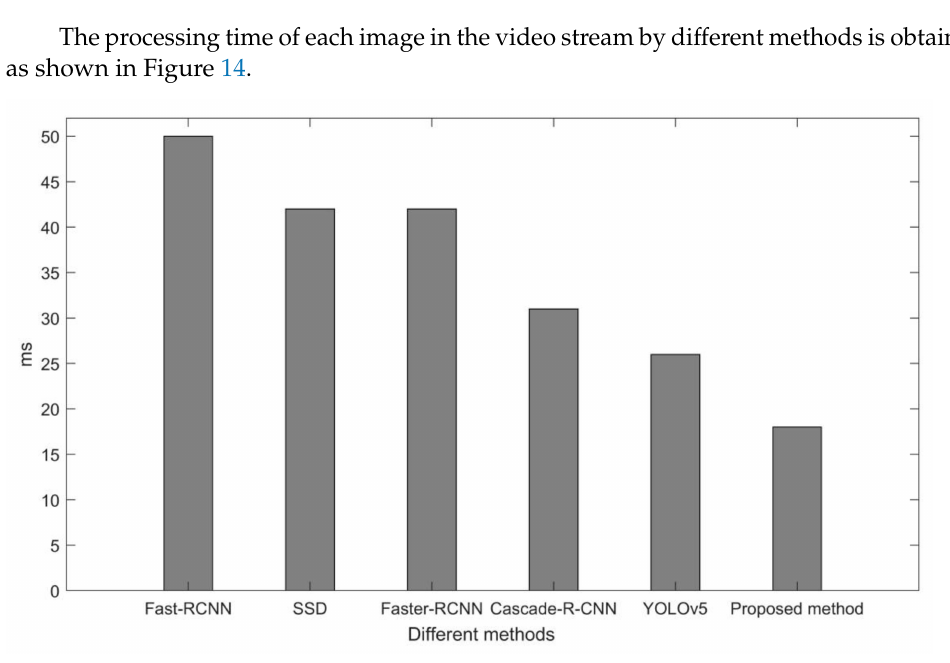
Figure 14. Processing time of each image by different